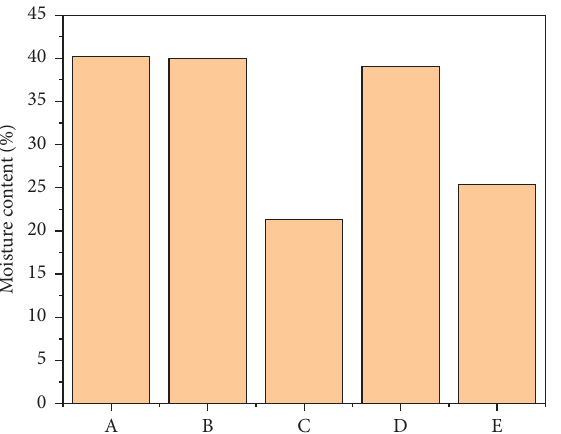
Figure 11: Moisture content: (a) freeze-dried MWCNT-reinforced IPMC; (b) freeze-dried common IPMC; (c) MWCNT-enhanced IPMC; (d) ordinary porous IPMC; (e) common IPMC.